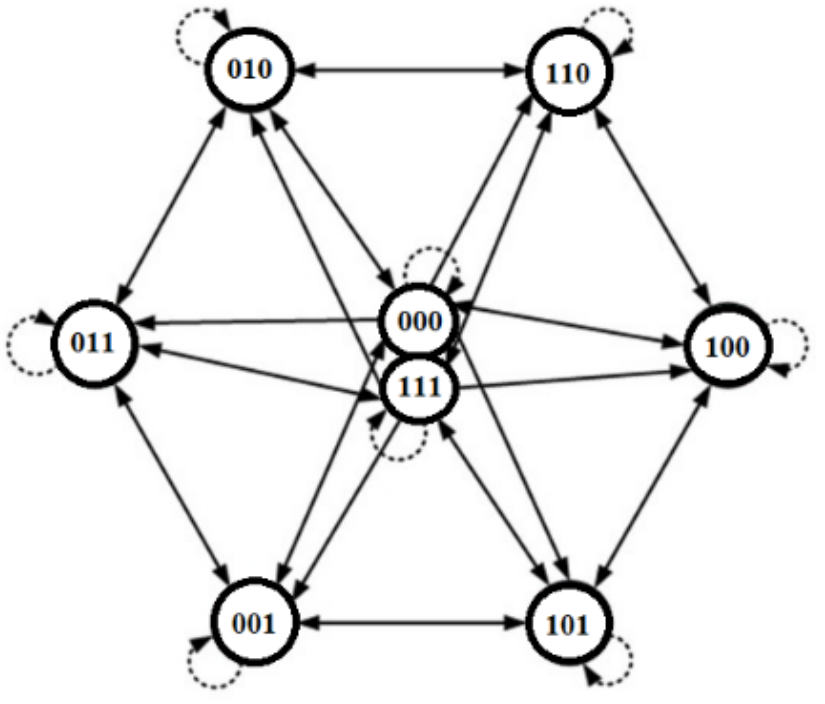
Figure 3. Selection of optimum switching vectors.